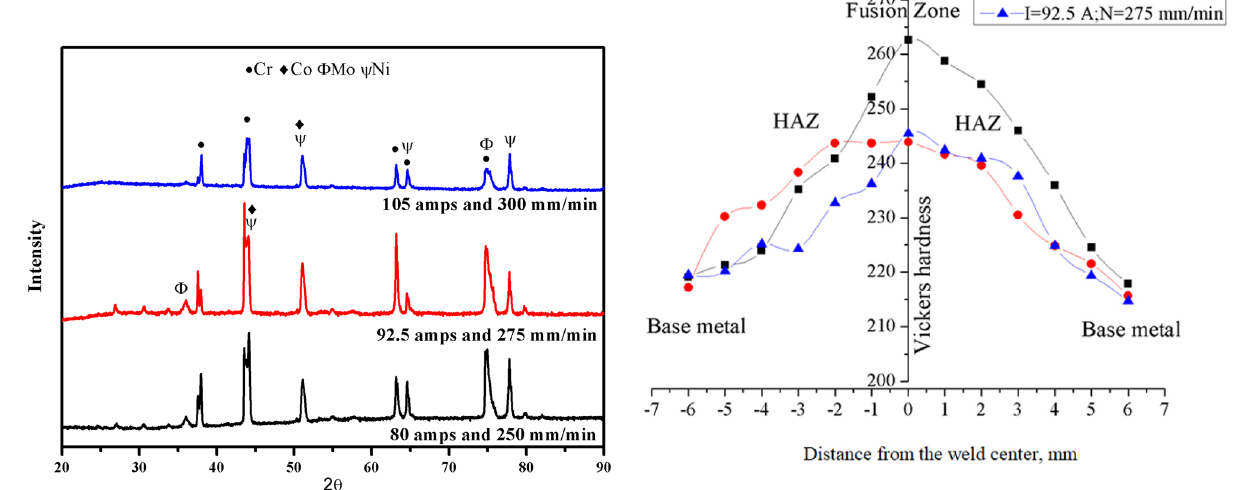
Figure 5: X - ray di ff raction patterns at the fusion zone.